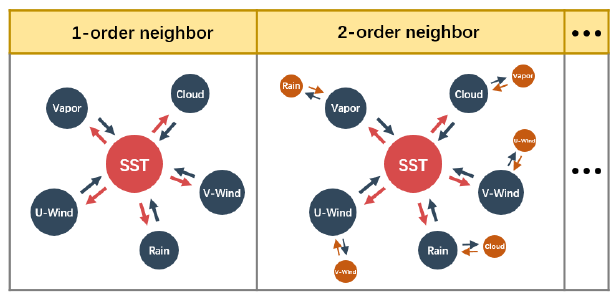
Figure 6. Multivariate coupling interactions within K -order neigh- bors (taking SST as the